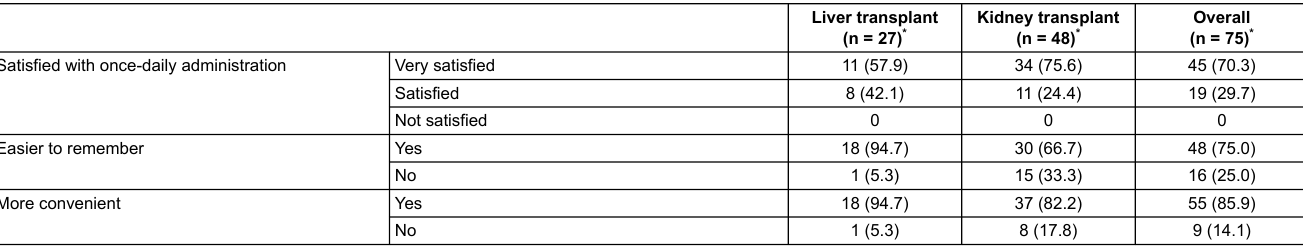
Liver transplant Kidney transplant Overall (n = 27) * (n = 48) * (n = 75) *